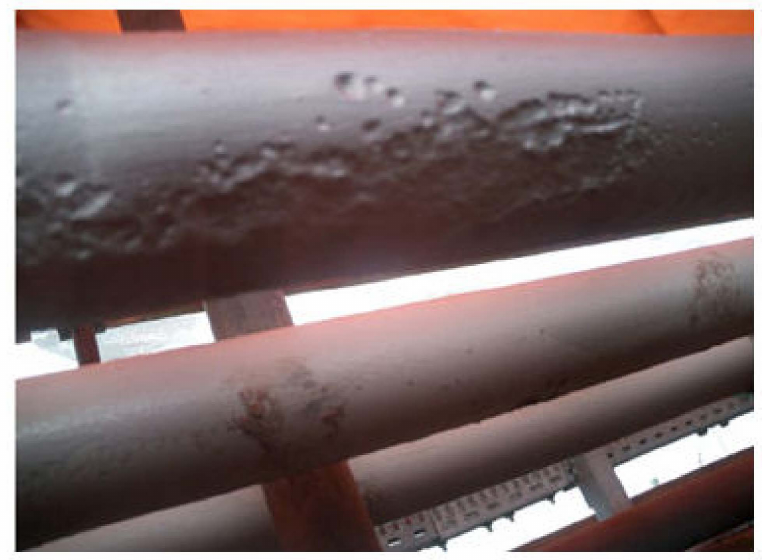
Figure 14. Coating degradation in the form of chained pitting. Reprinted with permission from Ref. [109] Copyright 2013 Springer